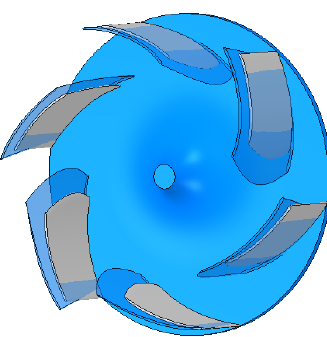
Figure 14. Comparison of 3D geometries of baseline (grey) and the optimal design (blue).